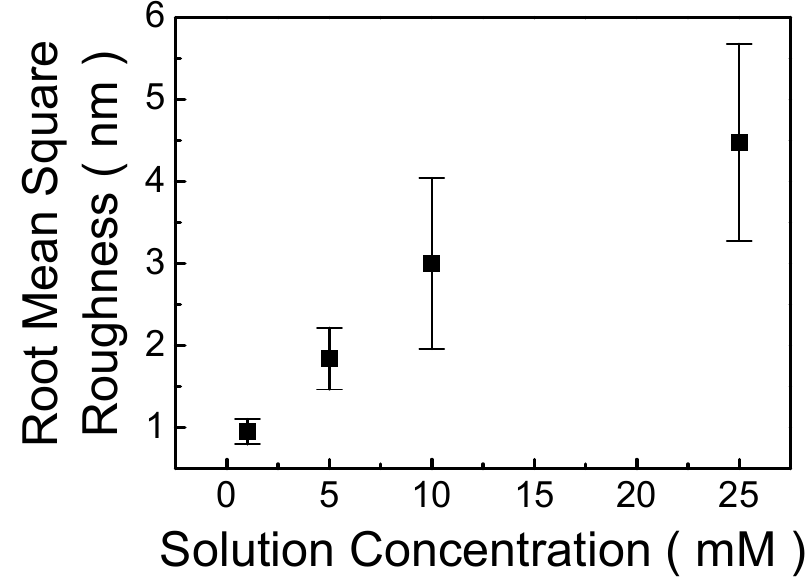
Figure 4. Room temperature PL spectra of MP8B films deposited on different substrates.